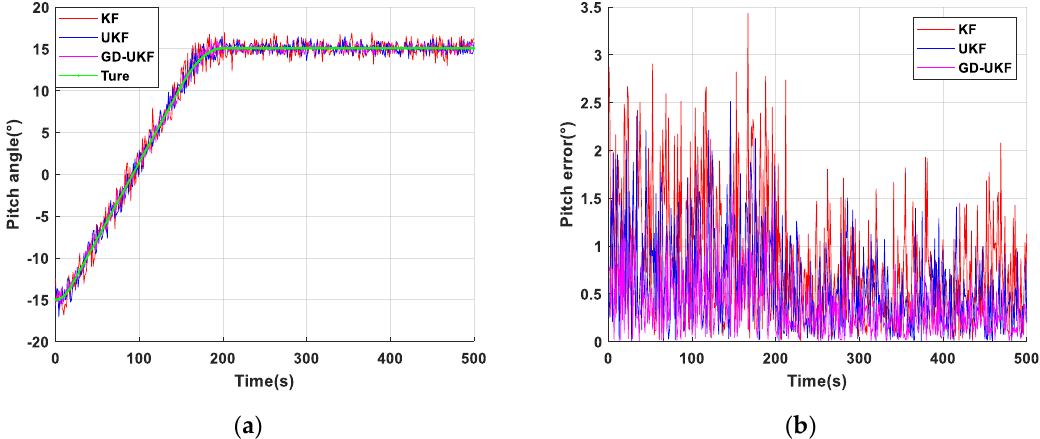
◦ ◦ and 0.5 , respectively.